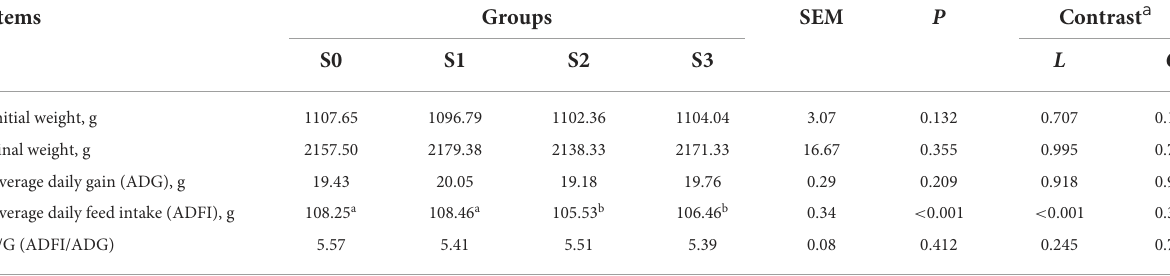
TABLE 2 Effects of diets supplemented with BMFA on the growth performance of broilers.